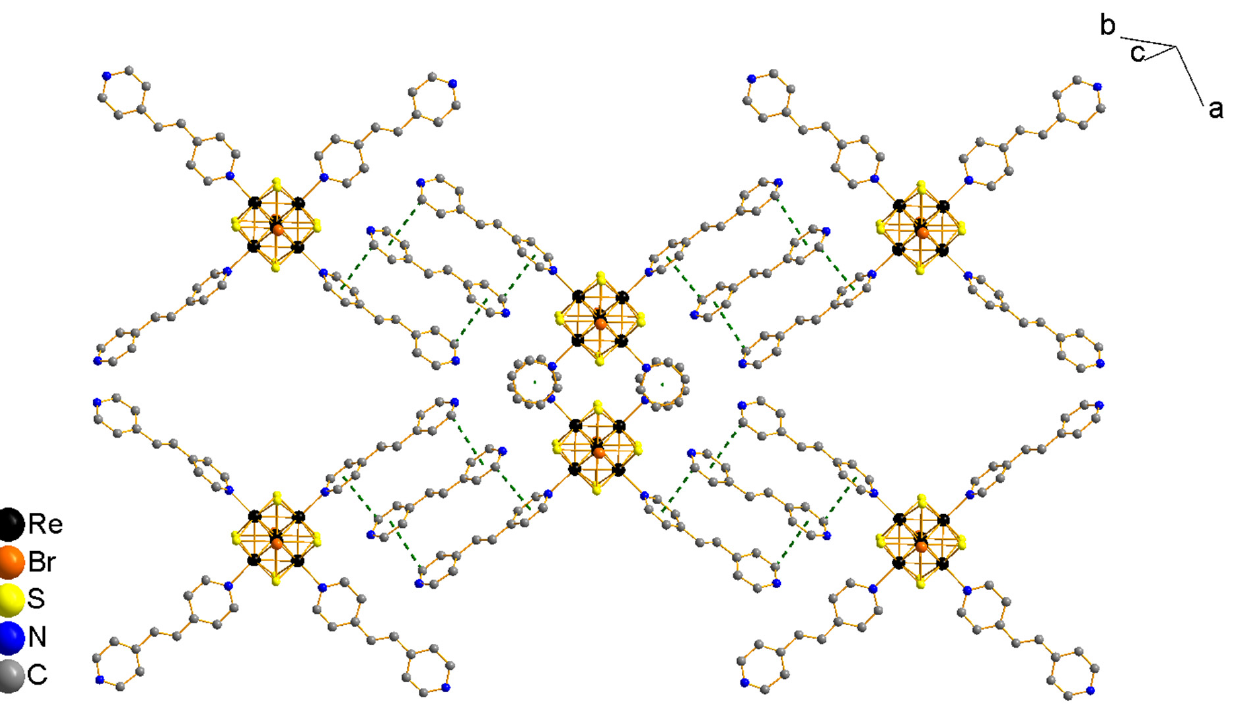
Figure 5. Packing fragment of cluster fragments in the structure of compound 1 · solv . Solvate bpe molecules and parts of the ligands that do not form weak interactions in this plane are not shown.